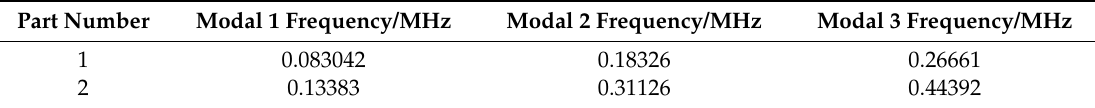
Table 1. First three modal frequencies of each part of the inductor with auxiliary pillar.